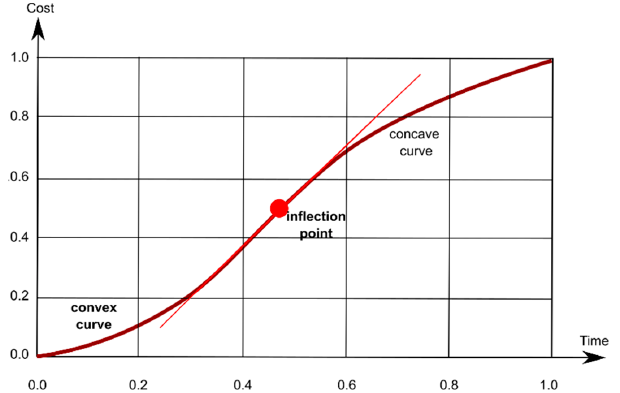
Figure 5. Cost curve with inflection point.